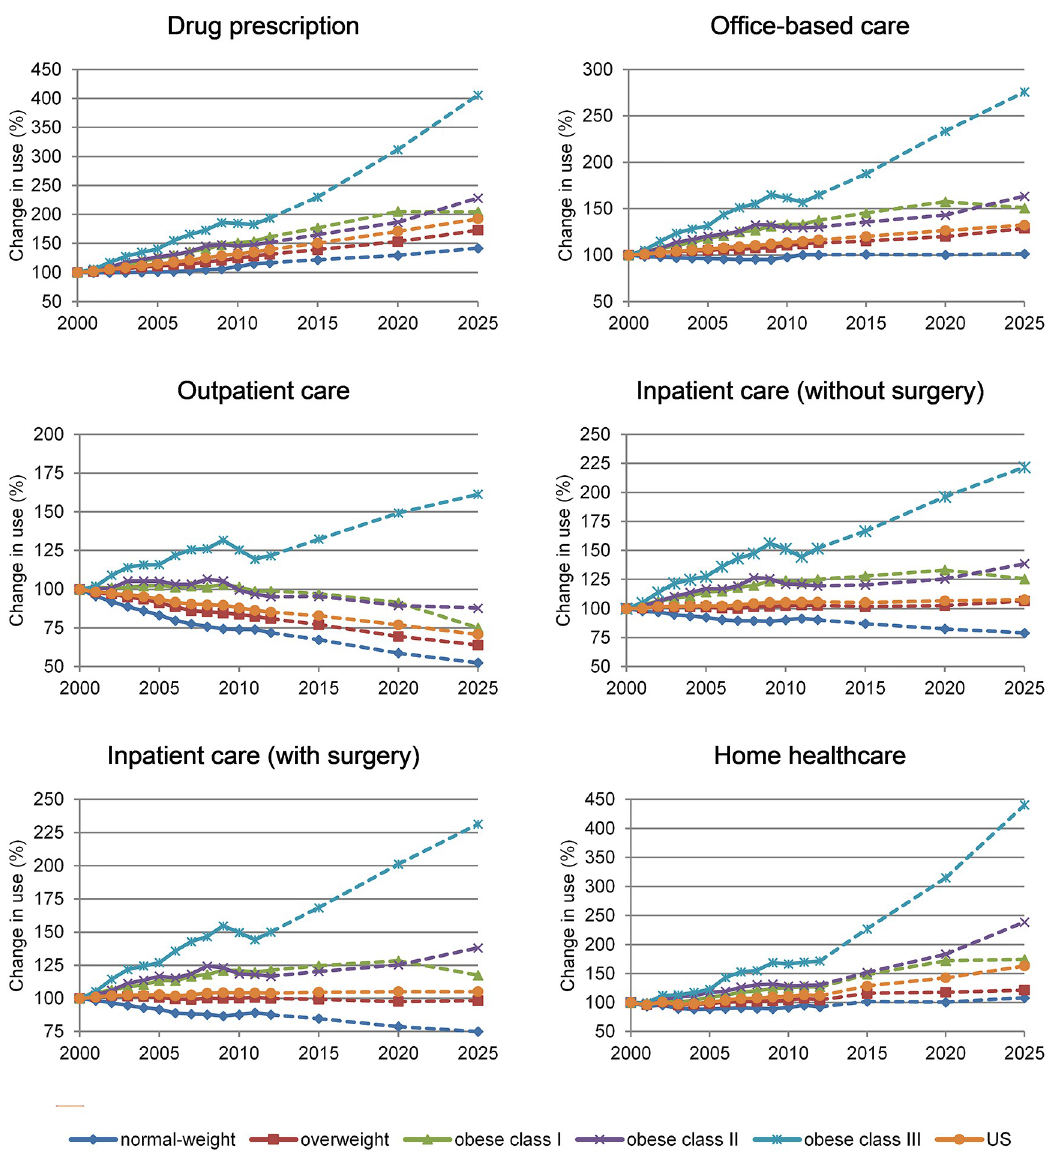
Fig 1. Change in use of healthcare services (%) by category of service and BMI; US population 2000–2025. Note: continuous lines represent historical trends; dotted lines represent projections; BMI (Body Mass Index) categories are defined according to WHO thresholds (WHO 2016) for adults and Cole et al. 2000 for children and teenagers; 2000 is base year equal to 100; additional results in the S1